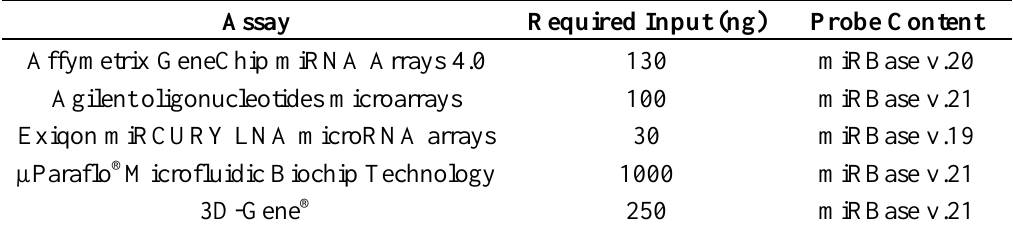
Table 4. Summary of microarrays for